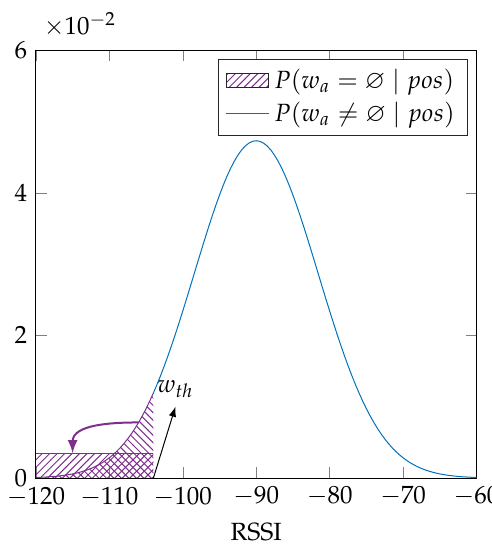
Figure 2. Our sensor model explicitly allows an access point to be not received, indicating it as having an RSSI value lower than the threshold RSSI value w th